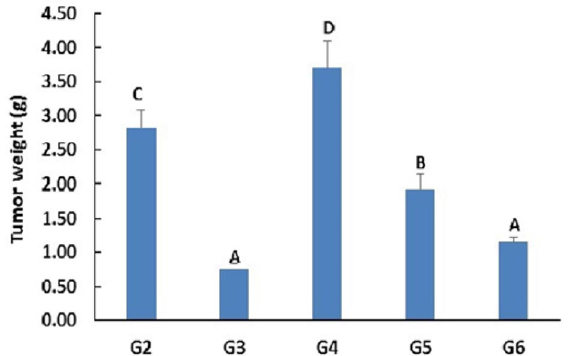
Figure 3. The weight of tumor (g) of tumor bearing groups. Data is displayed as mean ± standard error. G2: tumor control group, G3: doxorubicin-treated group, G4–G6: groups treated with 5, 10 & 20% of PSO nano- emulsion LD50, respectively. Means marked with the same superscript letters are insignificantly ( p > 0.05) different, whereas those marked with different ones are significantly ( p < 0.05) different.